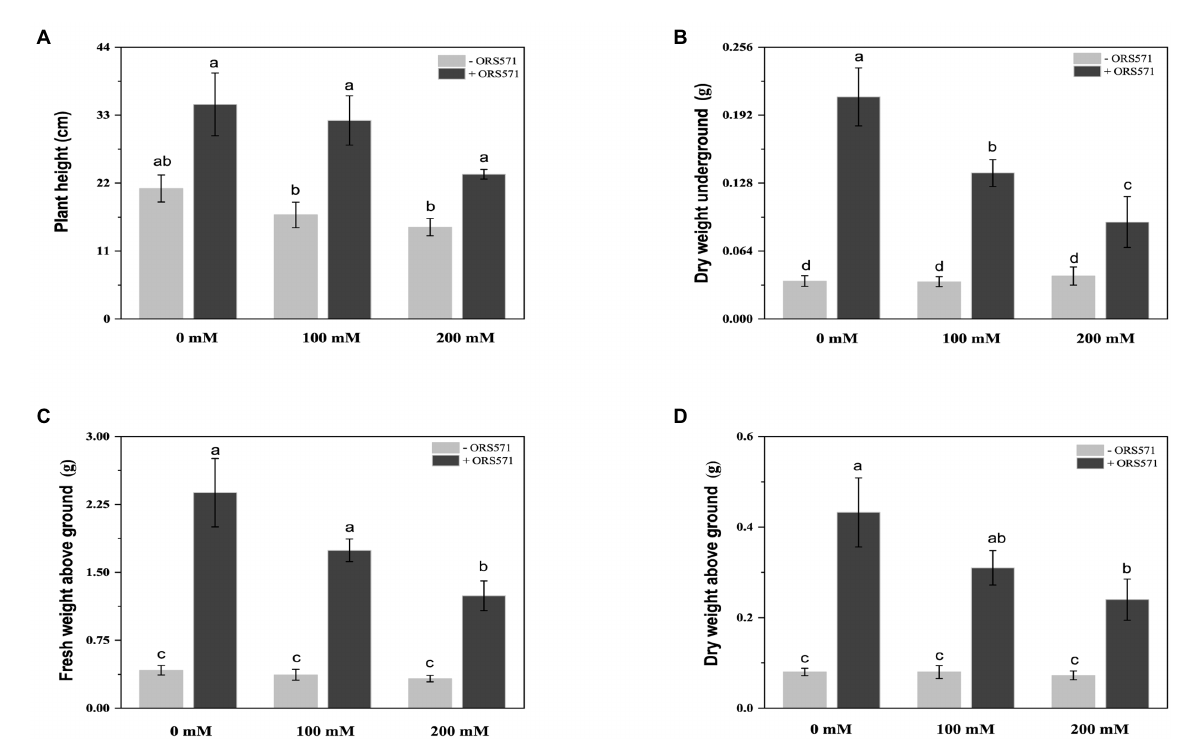
FIGURE 2 Effects of inoculation with ORS571 on the biomass of Sesbania rostrata under different salt concentrations. The plant height (A) , DW underground (B) , FW above ground (C) , DW above ground (D) were measured. Different lower-case letters in each column shape indicate a significant difference at p < 0.05 by statistical analysis. Error bars indicate standard deviations from four parallel